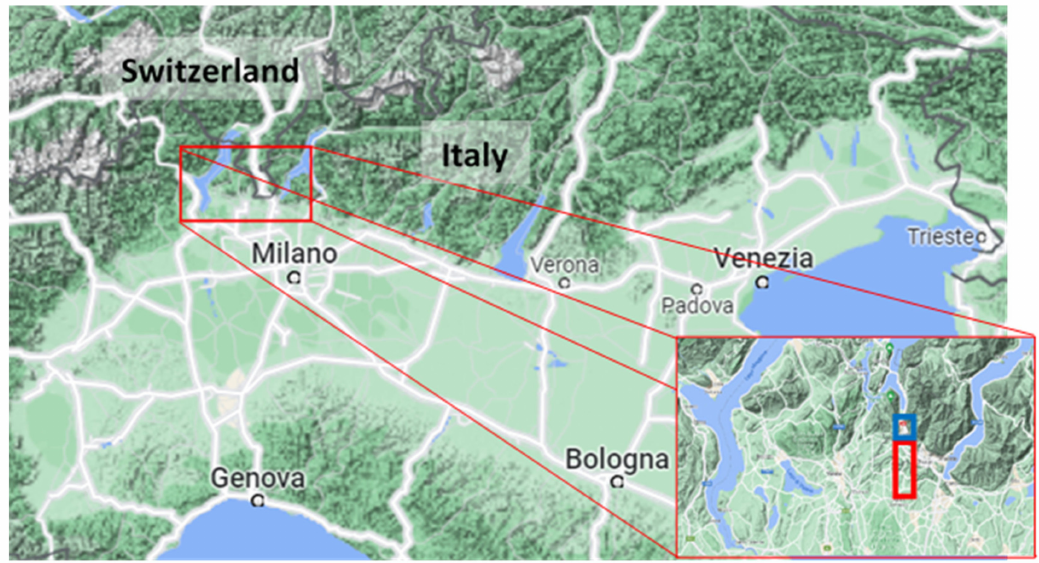
Figure 1. Approximate location of the Lura (red) and Laveggio (blue) river basins in their sub-alpine territorial context. Map data ©